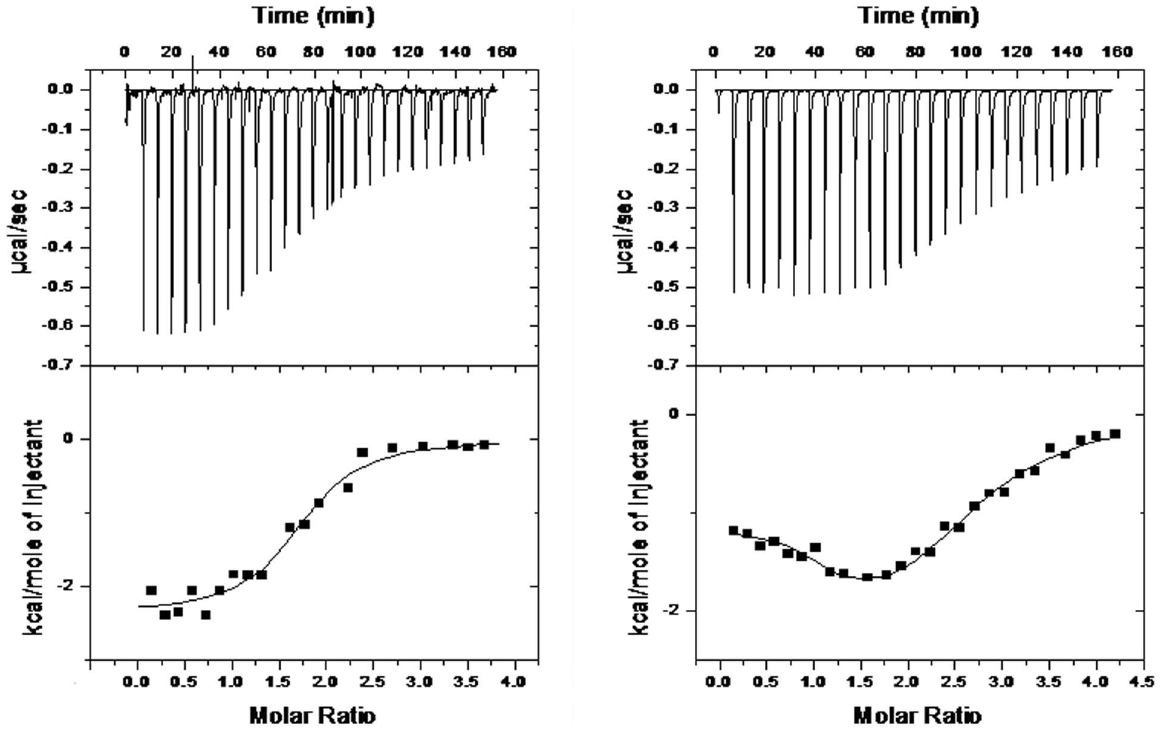
Figure 2. (K34) 2 Ni(II) shows different binding profiles towards wtTel26 and Tel26 at 25 6 C. ITC profiles corresponding to the titration of 25 m M wtTel26 (Panel A) or Tel26 (Panel B) with (K34) 2 Ni(II) at 25 u C in 10 mM Tris, 20 mM KCl, pH 7.5. Raw ITC data (top panel) and binding isotherms (bottom panel). doi:10.1371/journal.pone.0058529.g002 Table 2. Thermodynamic parameters derived from ITC titrations describing the interaction of (K34) 2 Ni(II) with